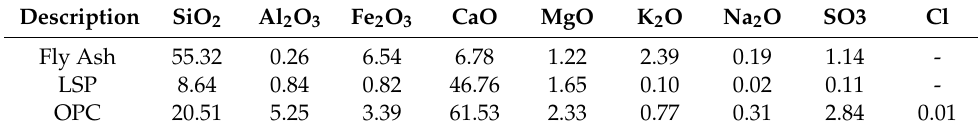
Figure 1. Sieve analysis of the coarse aggregate and fine aggregate. Table 2. Chemical composition of raw materials (wt %age). LSP, lime stone powder; OPC, Ordinary Portland Cement.